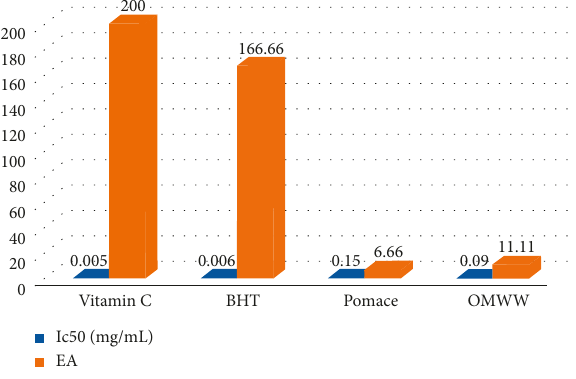
Figure 3: IC 50 and EA of the tested